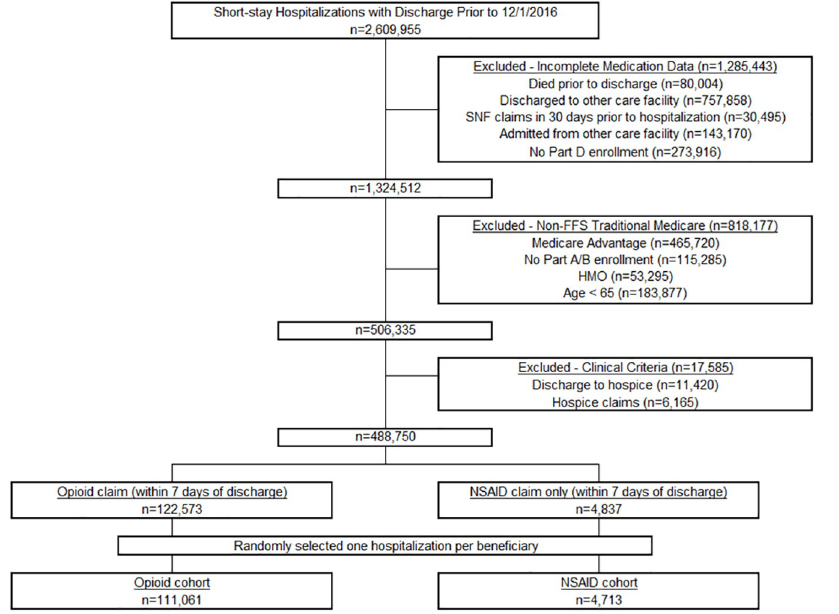
Fig 1. Study consort diagram. CMS, Centers for Medicare and Medicaid Services; FFS, fee for service; HMO, health maintenance organization; NSAID, nonsteroidal anti-inflammatory drug; SNF, skilled nursing facility.